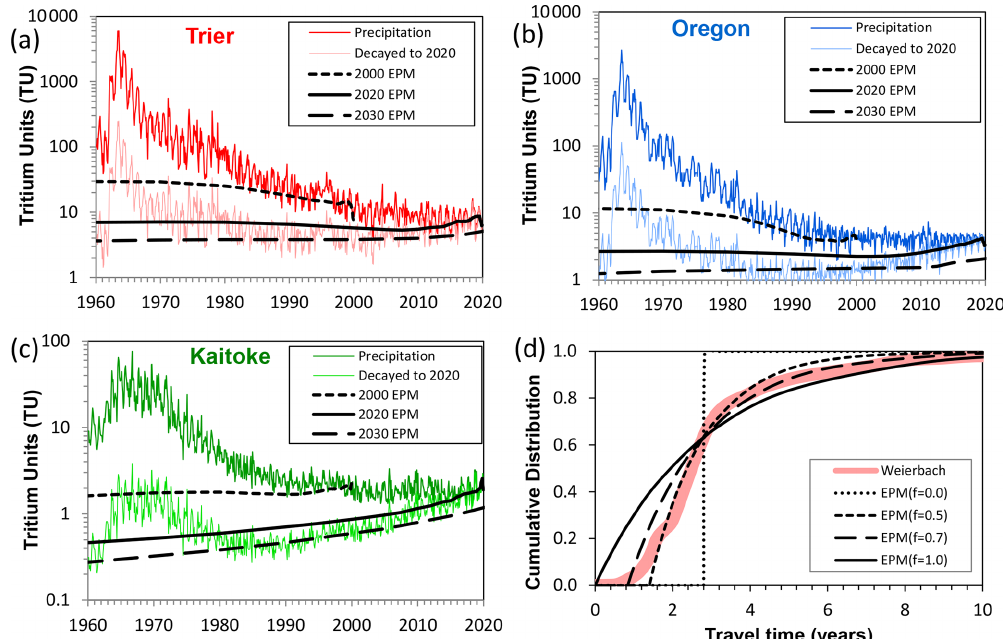
Figure 1. Tritium concentration in precipitation in (a) Trier, Germany, (b) Oregon, USA, and (c) Kaitoke, NZ, after accounting for radioactive decay up to 2020 and after mixing of the decayed concentrations using an EPM( f = 0 . 7) model (black curves). (d) Comparison of flow- weighted cumulative stream distribution from the Weierbach Catchment (Fig. 7c, Rodriguez et al., 2021) with cumulative EPM